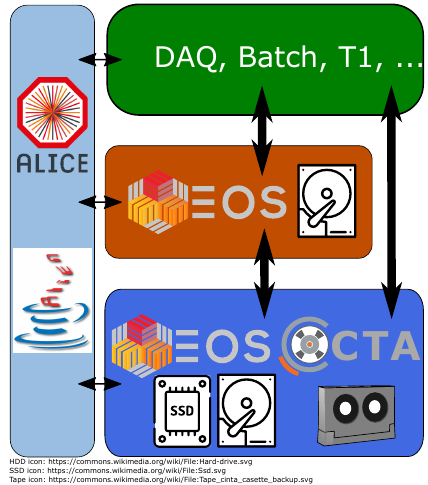
Figure 2. CTA deployment model for the ALICE experiment with SSD and HDD storage tiers for the